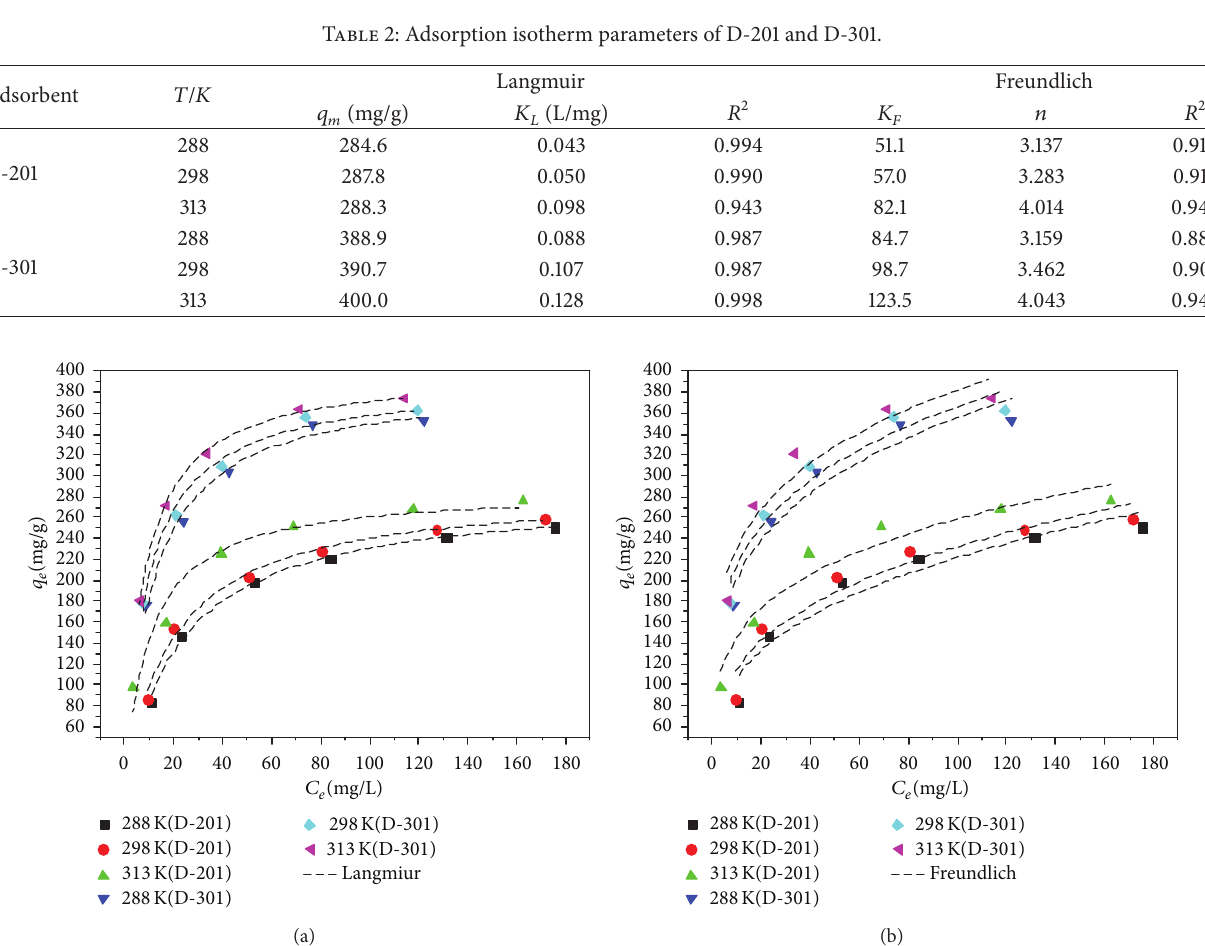
Figure1:EquilibriumadsorptionisothermsofMBPonD-201andD-301.(a)FittingbyLangmuirequation.(b)FittingbyFreundlichequation.